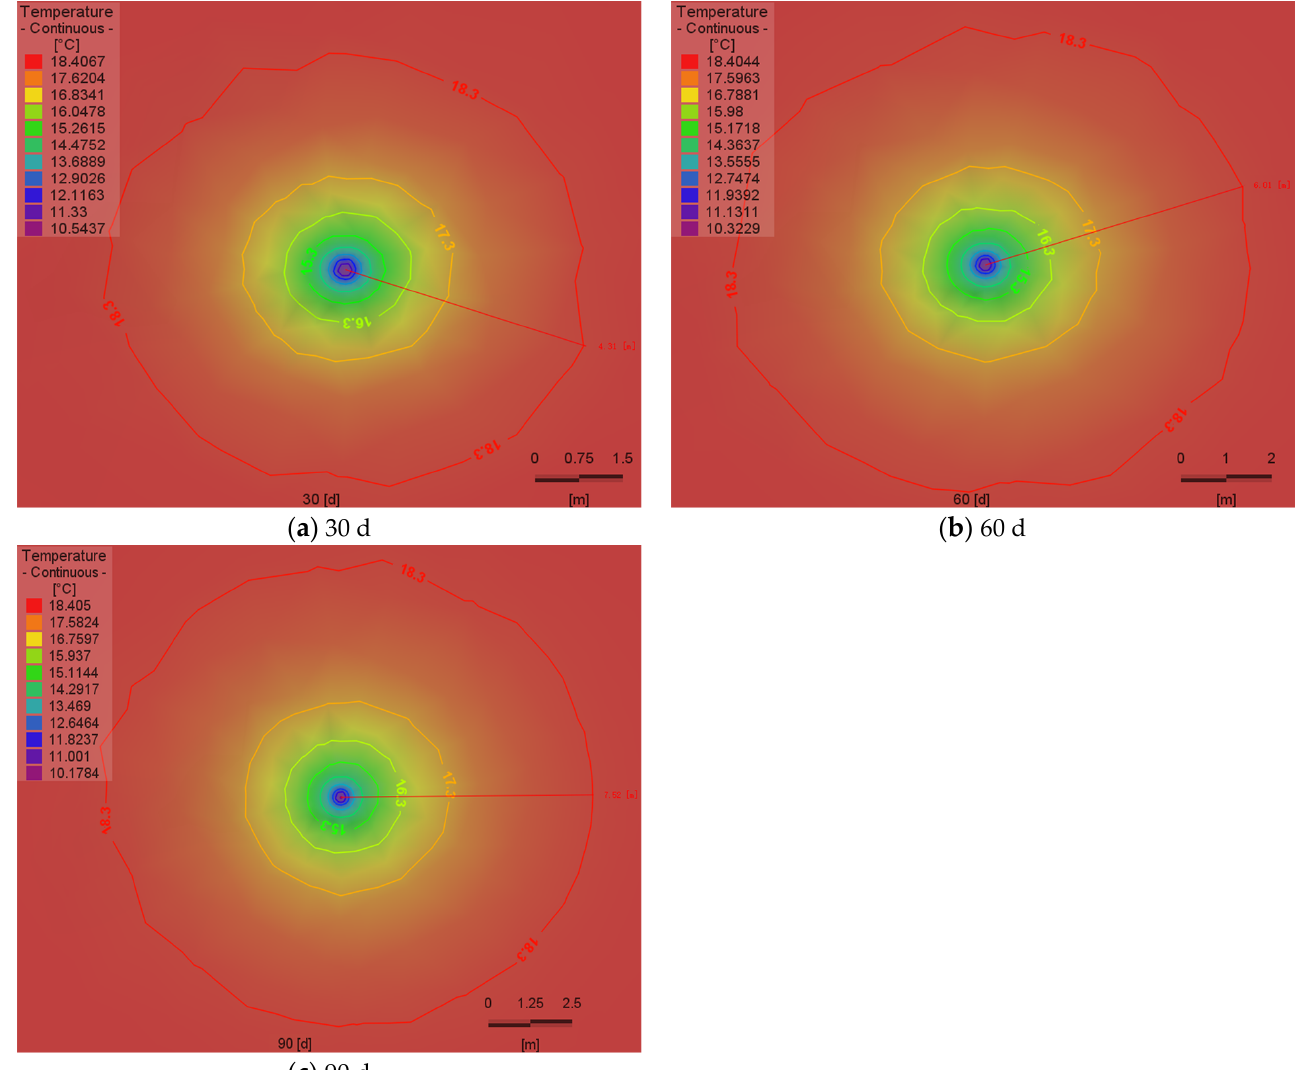
Figure 5. Ground temperature field diagram around the BHE during the heating period under the operation of a single heat exchanger.